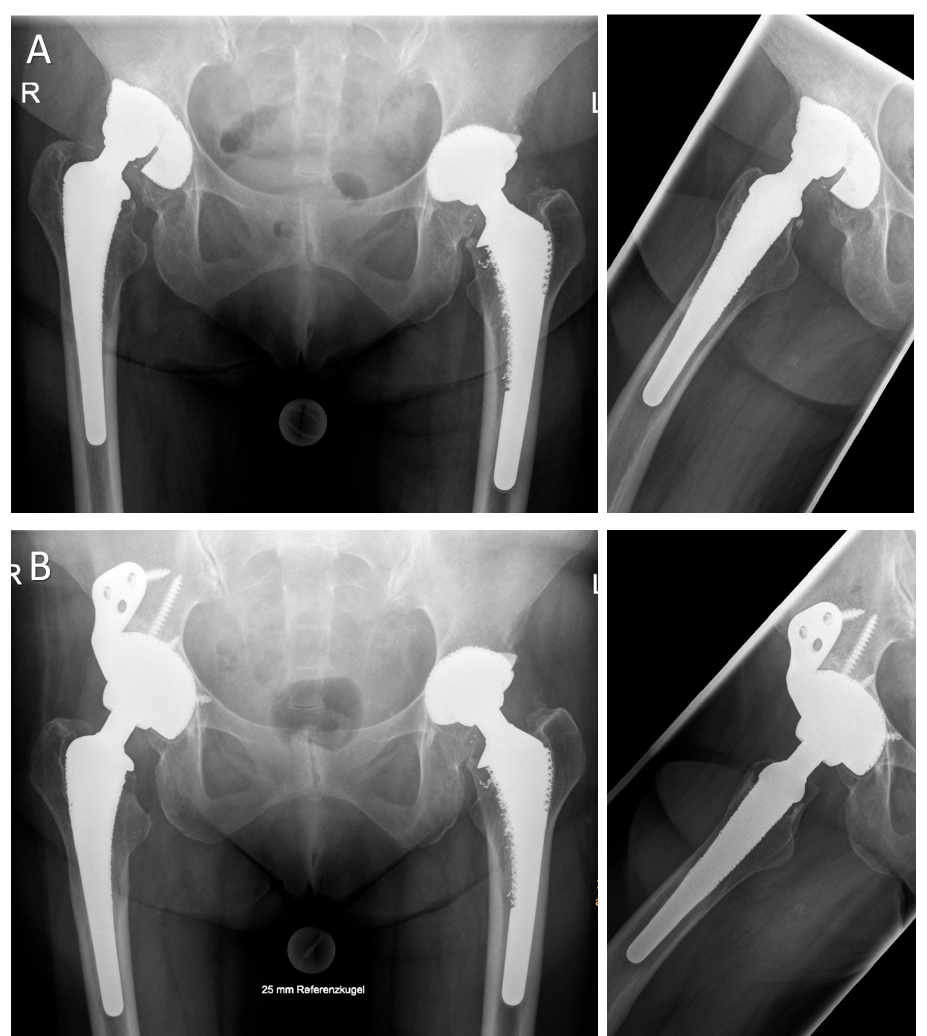
Figure 2. ( A ) A 63-year-old female patient with failure of the acetabular implant and subsequent cranial migration 18 years after the index procedure (a.p. and axial views). Intraoperative defect evaluation revealed a large uncontained cranio-lateral defect (“up-and-out”) with rim destruction of more than 30% (Paprosky type IIIA defect). ( B ) Radiographs 24 months postoperatively revealed a stable acetabular implant augmented with multiple screws through the implant’s body and the iliac flange (HHS: 25 preoperatively, 81 postoperatively; OT 79 min).